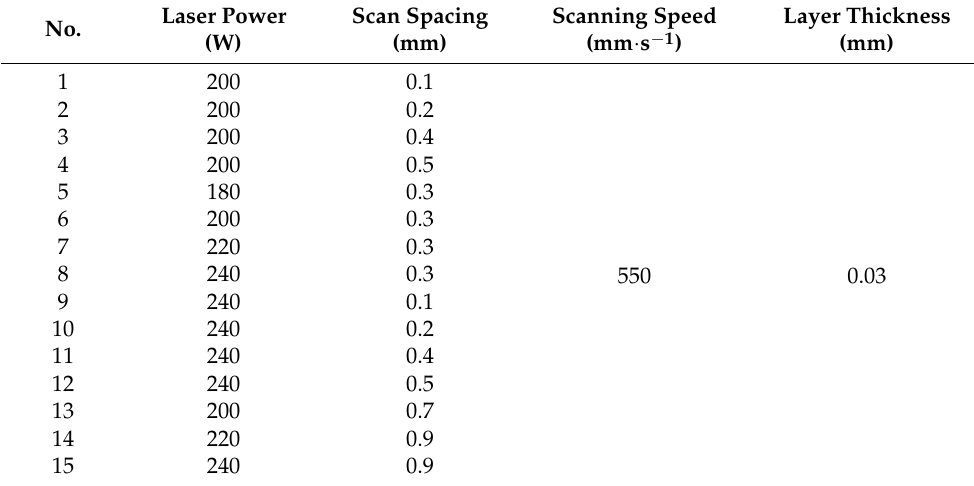
Table 3. Forming process parameters for the grid structures using L-PBF.